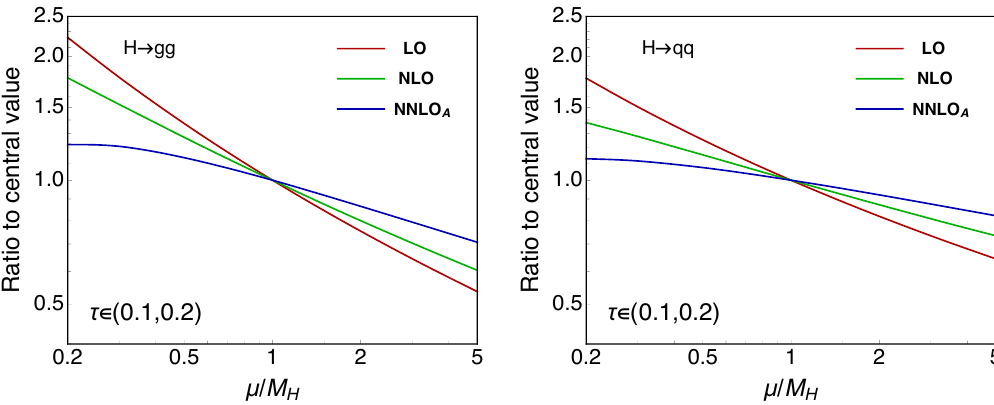
Figure 9 . The ratios of the integrated cross sections in the bin (cid:28) 2 [0 : 1 ; 0 : 2] to their central values at (cid:22) = m H , as a function of (cid:22)=m H